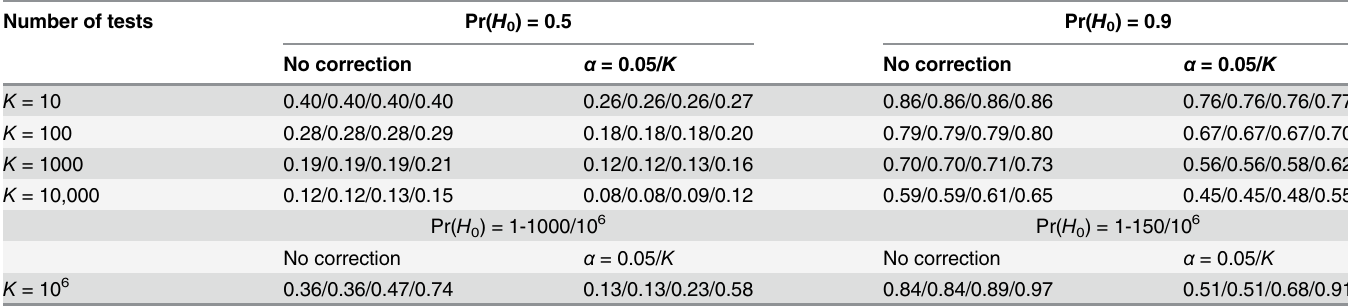
Table 1. Probability that the minimum P-value is a false finding. Table entries W/X/Y/Z give the true probability (W), followed by the estimated probabili- ties using the integration method (X); the discretization method (Y); the distribution mean method (Z). Sample sizes ( n 1 , n 2 : number of cases, controls in allele counts): n 1 + n 2 = 800 for K = 10 to 10,000; n 1 + n 2 = 4000 for K = 10 6